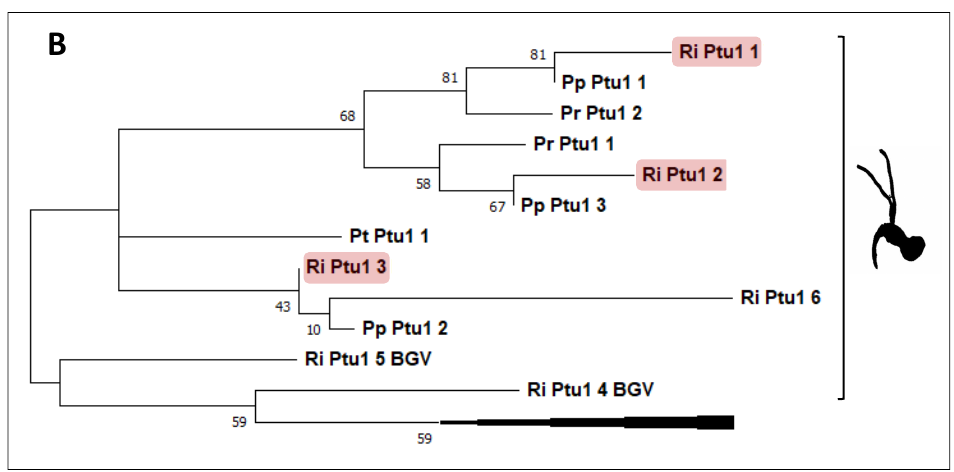
Figure 13. Characterization of Ptu1 family peptides. ( A ) Alignment of Ptu1 family peptides from Rhyno- coris iracundus (Ri_Ptu1_V1, Ri_Ptu1_V2, (Ri_Ptu1_BGV3-Ri_Ptu1_BGV6), P. rhadamanthus (Pr_Ptu1_1 and Pr_Ptu1_2), P. plagipennis (Pp_Ptu1_1, Pp_Ptu1_2, Pp_Ptu1_3), P. turpis (Pt_Ptu1_1), and their homolog ω -conotoxins (MVIIA, MVIIB, GVIIA/GVIIB, CVID) from cone snails. The structure of Ptu1 family peptides includes three disulfide bridges (I, II, III) connecting six conserved cysteines, which are separated by four inter-cysteine loops. Residues playing a role in surface interaction such as aromatic residues (blue circle), acidic residues (black circle), and basic residues (green circle) are highlighted as published for Pt_Ptu1 and MVIIA. ( B ) Phylogenetic tree of Ptu1 family peptides. Ptu1 and ω -conotoxins mentioned above were used to generate a phylogenetic tree which was inferred by using the Maximum Likelihood method and Le-Gascuel model [46]. The tree with the highest log likelihood ( − 543.24) is presented. The cone snail image was created with